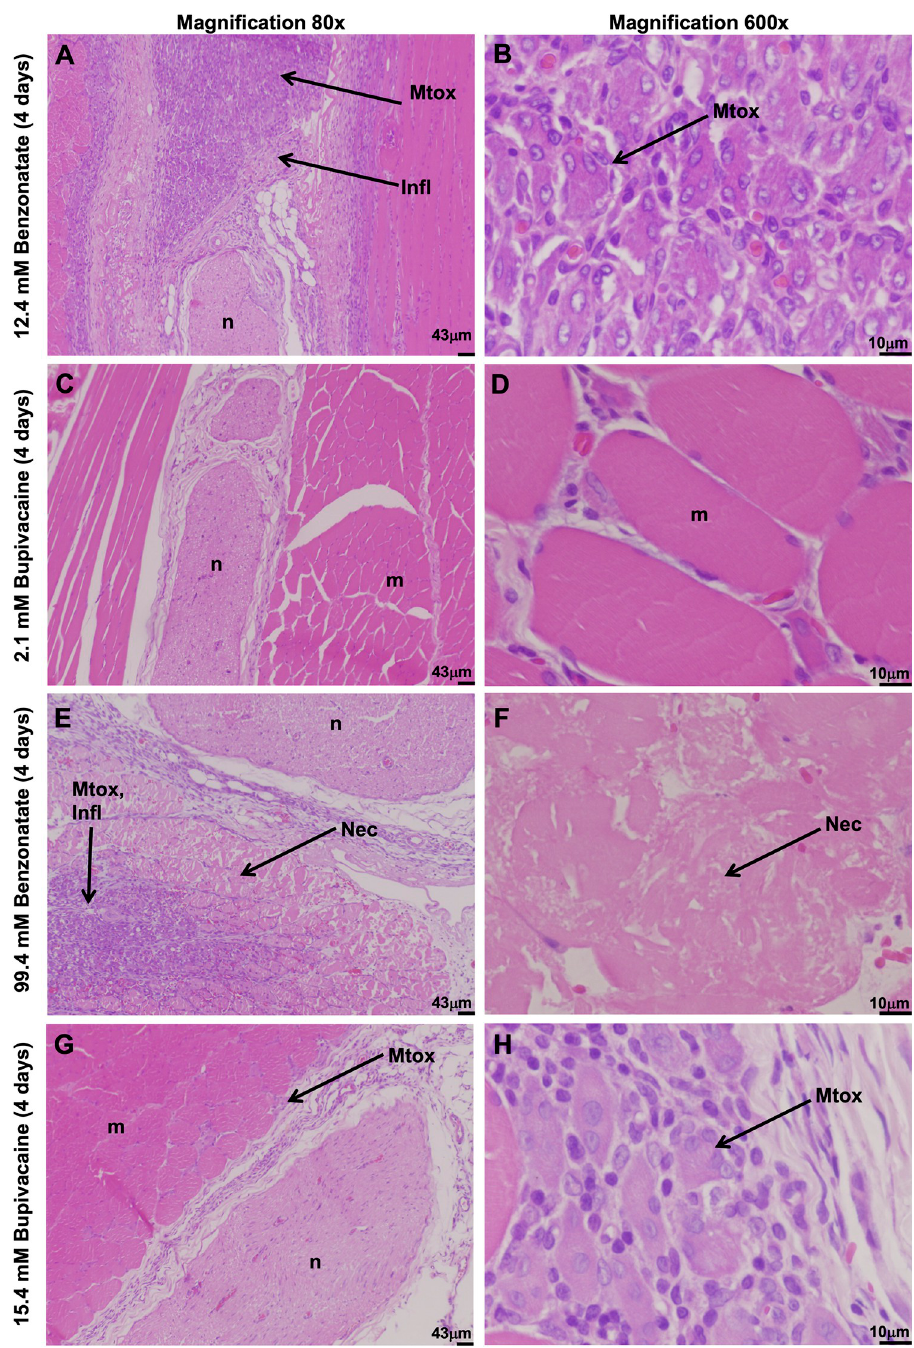
Fig 4. Representative light microscopy of hematoxylin/eosin-stained sections of nerves (n), muscles (m), and surrounding tissues at the site of injection. Tissues were collected 4 days after injection with equieffective concentrations of benzonatate and bupivacaine. Infl: Inflammation. Mtox: Myotoxicity. Nec: Necrosis. equieffective concentration of bupivacaine (15.4 mM) produced much less inflammation (p = 0.02) and myotoxicity (p = 0.02) with centralization of nuclei and only perifascicular mus- cle injury (Fig 4G and 4H).